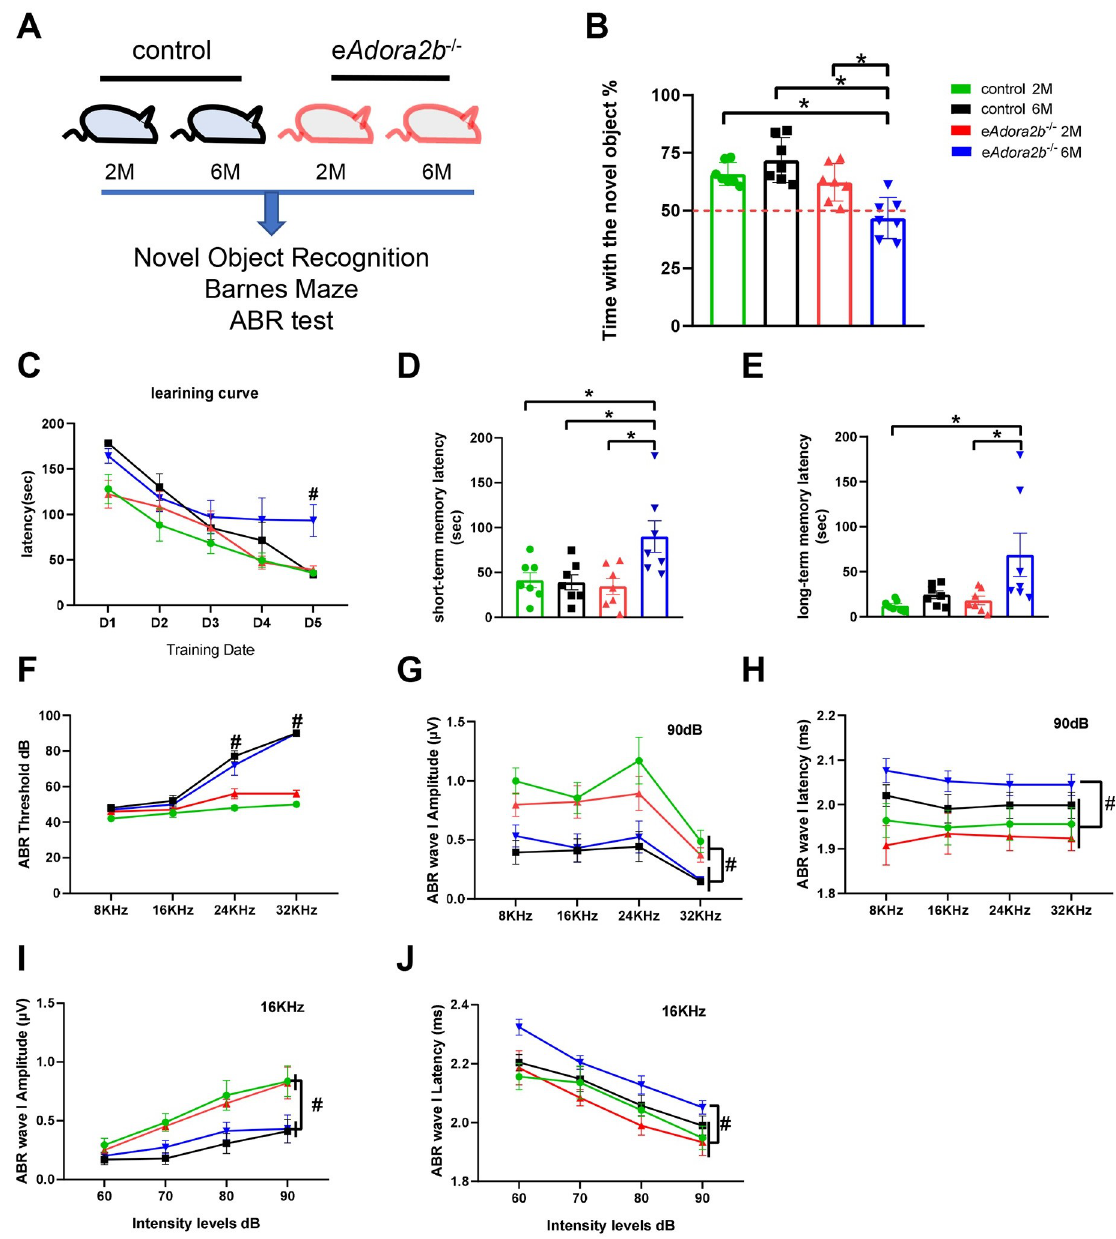
Fig 1. Erythrocyte ADORA2B deficiency impaired cognitive and cochlear function at 6 months. (A) Schematic representation of experimental design. Two-month-old and 6-month-old control and e Adora2b − / − mice cognitive and cochlear functions were evaluated by NOR, BM, and ABR test. (B) Percentage of time exploring the novel object was quantified in final trial of NOR, and a value lower than 50% demonstrated impaired cognitive abilities. Data are shown as mean ± SEM. n = 7 mice/group. � P < 0.05. (C) Learning curve was measured in the 4 groups for 5 consecutive days as the primary latency to find escape box in seconds. Data are expressed as mean ± SEM. n = 7 mice/ group. # P < 0.05 compared to other 3 groups. (D, E) Short-term memory (D) and long-term memory (E) were measured as the primary latency in seconds for mice to find the escape box. Data are shown as mean ± SEM. n = 7 mice/group. � P < 0.05. (F–J) ABR test was applied to measure HL of the 4 groups. Threshold (F) was defined as the lowest intensity to detect Waves I–V. Data are shown as mean ± SEM. n = 5 mice/group. # P < 0.05, e Adora2b − / − 6M and control 6M vs. e Adora2b − / − 2M and control 2M. Average Wave I amplitude (G) and latency (H) were measured in response to 90 dB. Data are shown as mean ± SEM. n = 5 mice/group. # P < 0.05. Average Wave I amplitude (I) and latency (J) were measured in response to 16 KHz. Data are shown as mean ± SEM. n = 5 mice/group. # P < 0.05. (G) and (I) were assessed by e Adora2b − / − 6M and control 6M vs. e Adora2b − / − 2M and control 2M. (H) and (J) were assessed by e Adora2b − / − 6M compared to other 3 groups. � P were measured by 1-way ANOVA with Tukey multiple comparison test. # P were tested by 2-way ANOVA with Tukey post hoc test. For all graphs, numerical data underlying plots are provided in S1 Data. ABR, auditory brainstem response; BM, Barnes Maze test; ADORA2B, adenosine A2B receptor; HL, hearing loss; NOR, novel object recognition. https://doi.org/10.1371/journal.pbio.3001239.g001 PLOS Biology | https://doi.org/10.1371/journal.pbio.3001239 June 17,